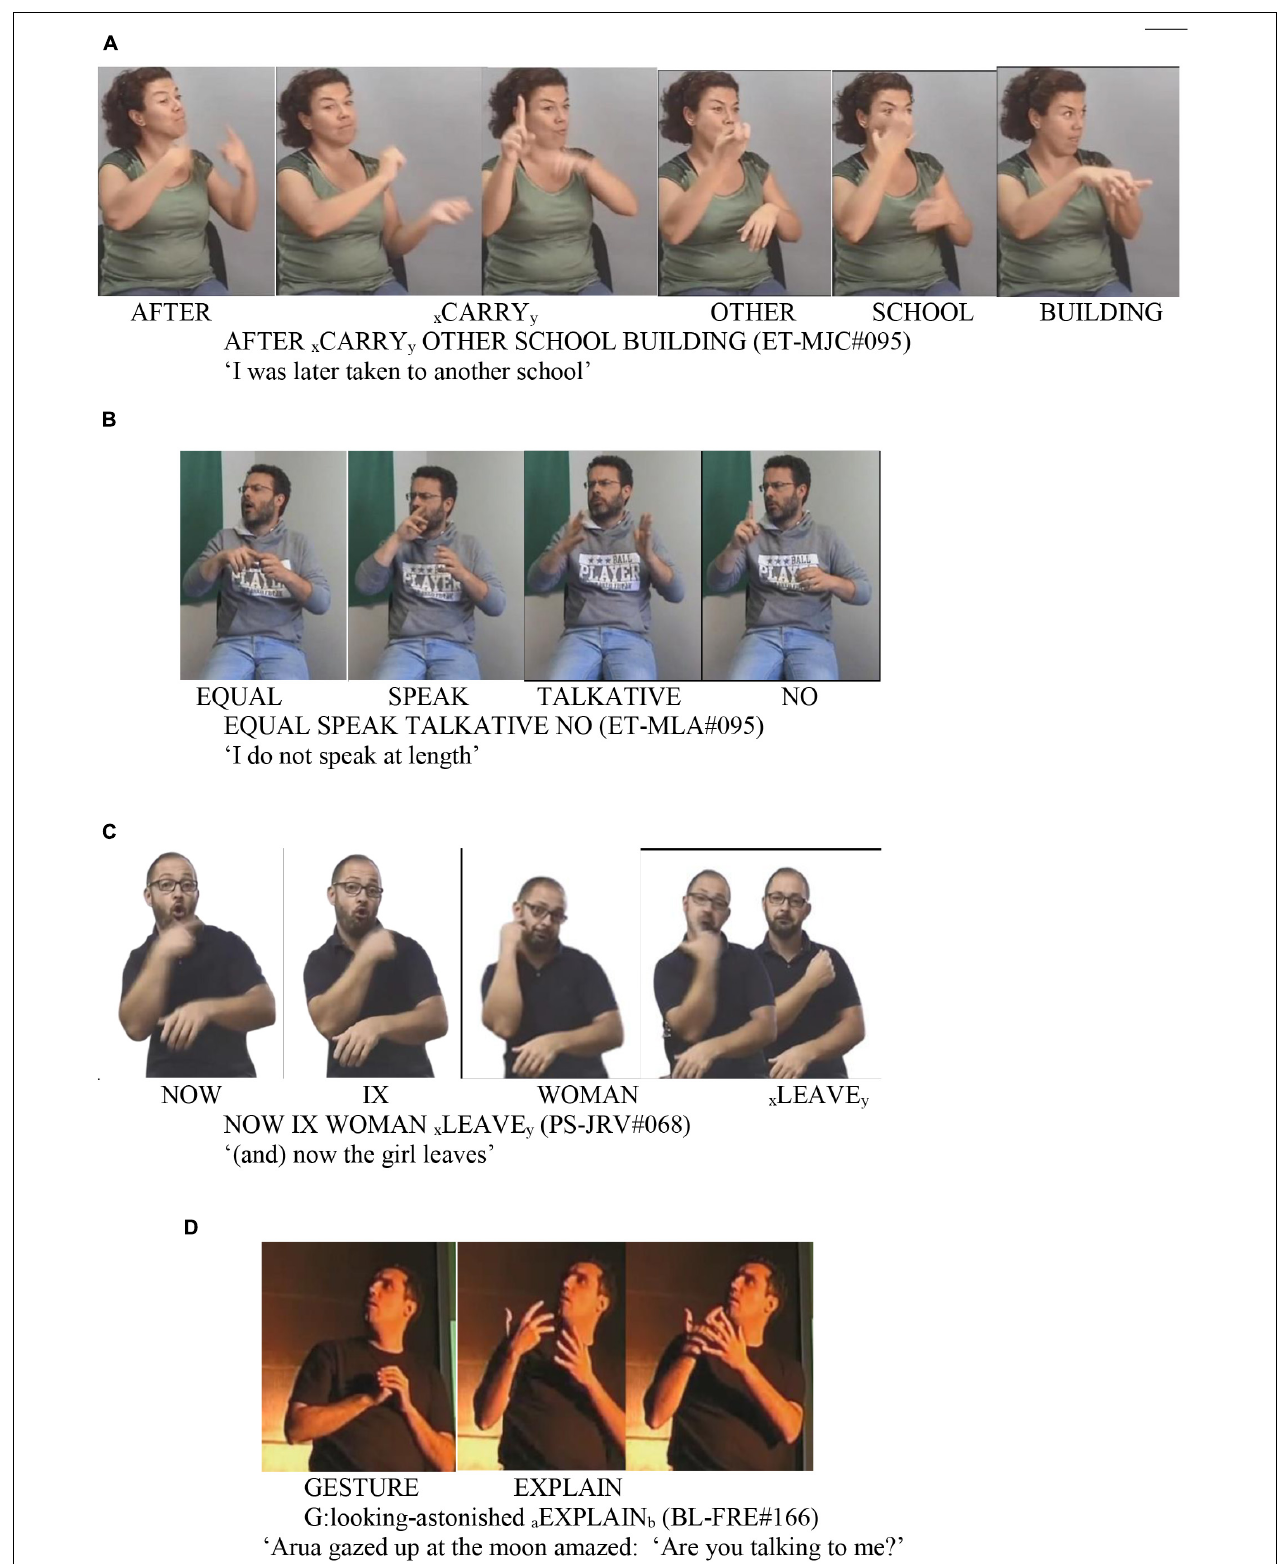
FIGURE 7 | Examples (A–D)